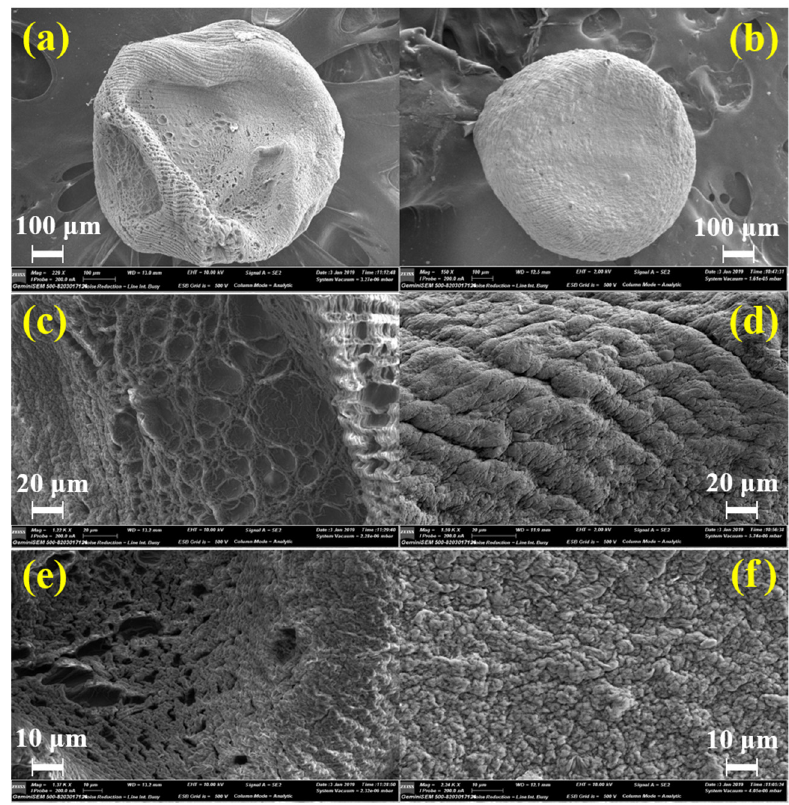
Figure 5. SEM micrographs of CA (( a ): 229 X, ( c ): 1.22 K X, ( e ): 1.37 K X) and CA-MTN (( b ): 150 X, ( d ): 1.59 K X, ( f ): 2.24 K X) microcapsules.